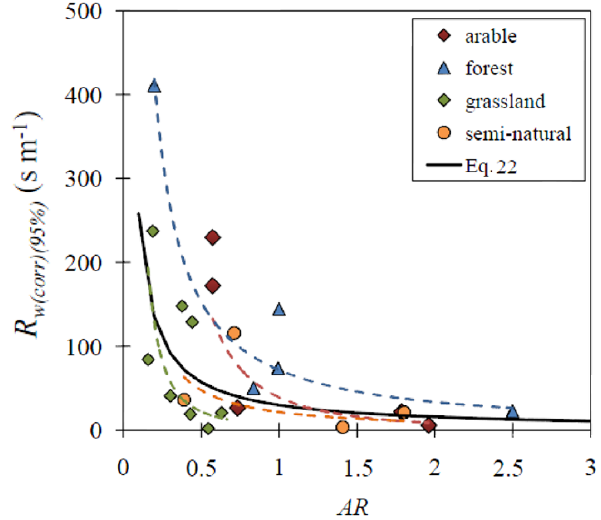
Fig. 6. External leaf surface resistance at 95% relative humid- ity ( R w ( corr )( 95% ) ) as a function of the ratio of Total Acids/NH 3 (AR = (2SO 2 + HNO 3 - + HCl)/NH 3 ) in the atmosphere separated according to ecosystem type. R w ( corr )( 95% ) was normalised for LAI and temperature. From Massad et al.